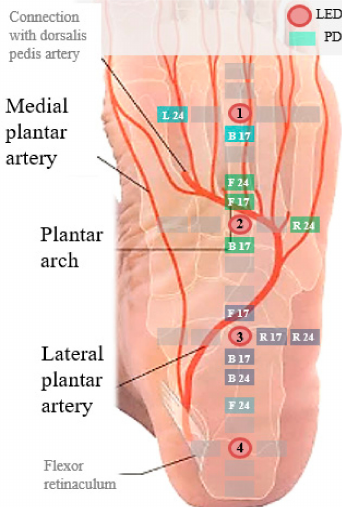
Figure 7. Top 12 LED-PD combinations superimposed on anatomical structure of the sole.